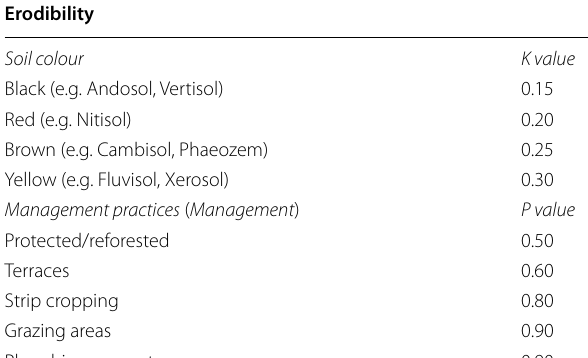
Table 1 K, C and P factors Hurni (1985)